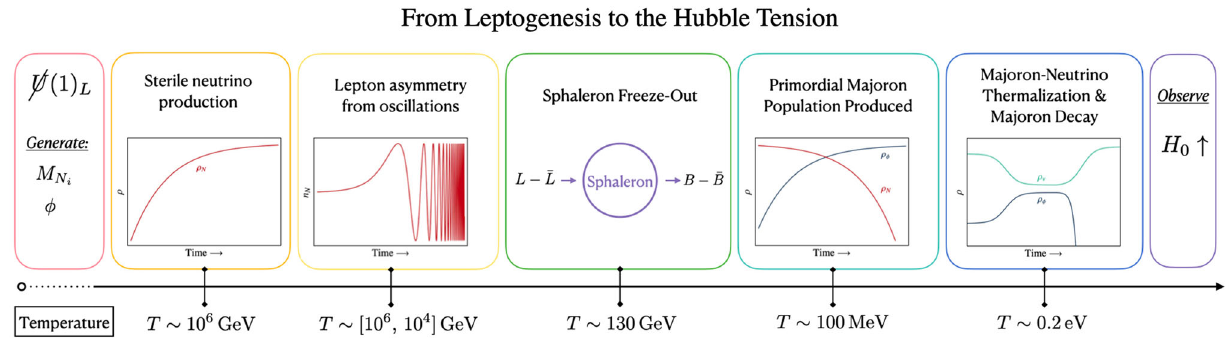
Fig. 1 Cosmologicaltimelineillustratingtheconnectionbetweenlow- scale leptogenesis and the majoron solution to the Hubble tension. At early times (high temperatures), a global U ( 1 ) L symmetry is sponta- neously broken, generating sterile neutrino masses and giving rise to a pseudo-Goldstone boson: the majoron ( φ ). Sterile neutrinos start to be sizeably produced (but do not equilibrate) at T ∼ 10 6 GeV. Then, at T ∼ [ 10 6 − 10 4 ] GeV the CP violating oscillations of these sterile neutrinos generate a net primordial lepton asymmetry in the Standard Model. Soon after the electroweak phase transition (at T ∼ 130 GeV)